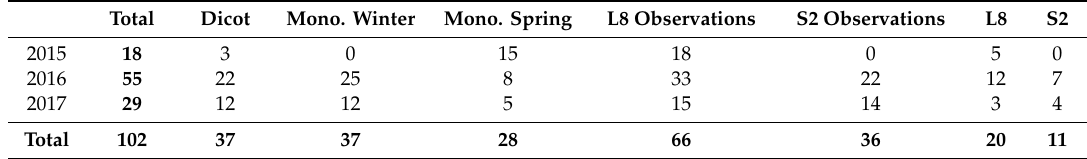
Table 3. Summary table of field sampling plots for each year, crop type, and sensor